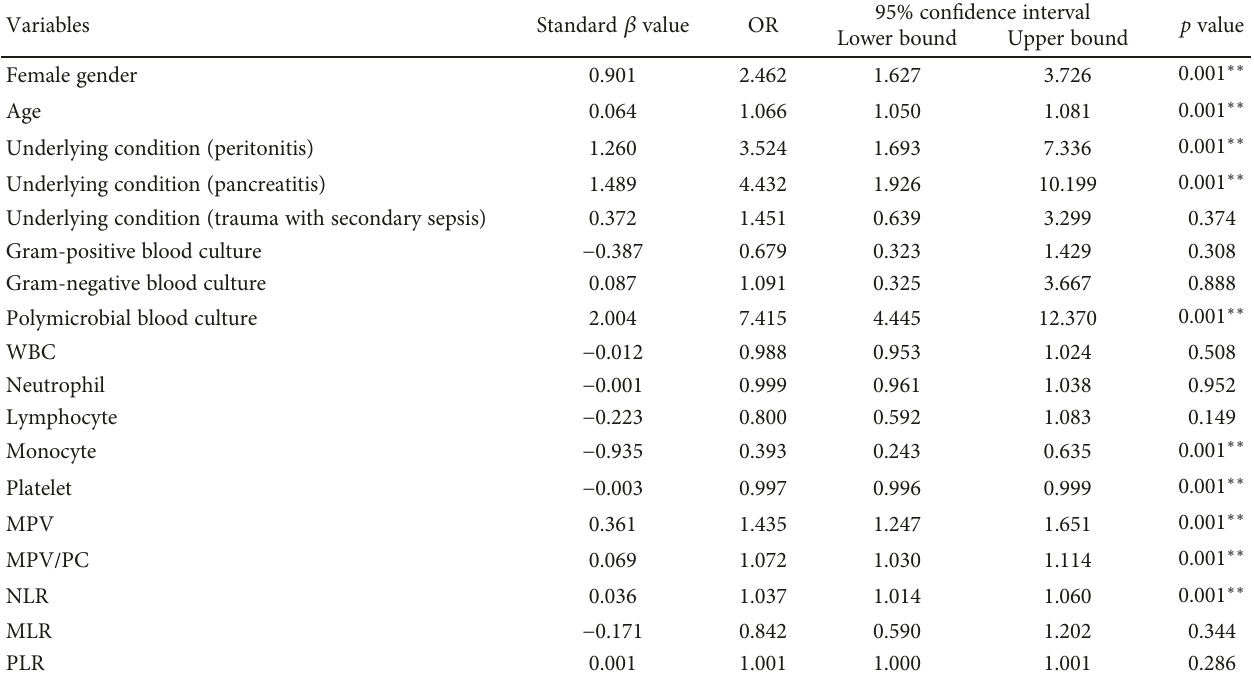
Table 5: Univariate odds ratios of variables for predicting lethal outcome in all patients.